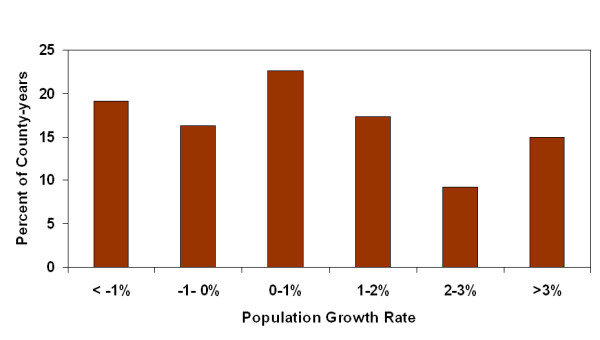
Frequency distribution of county-year population growth rates.